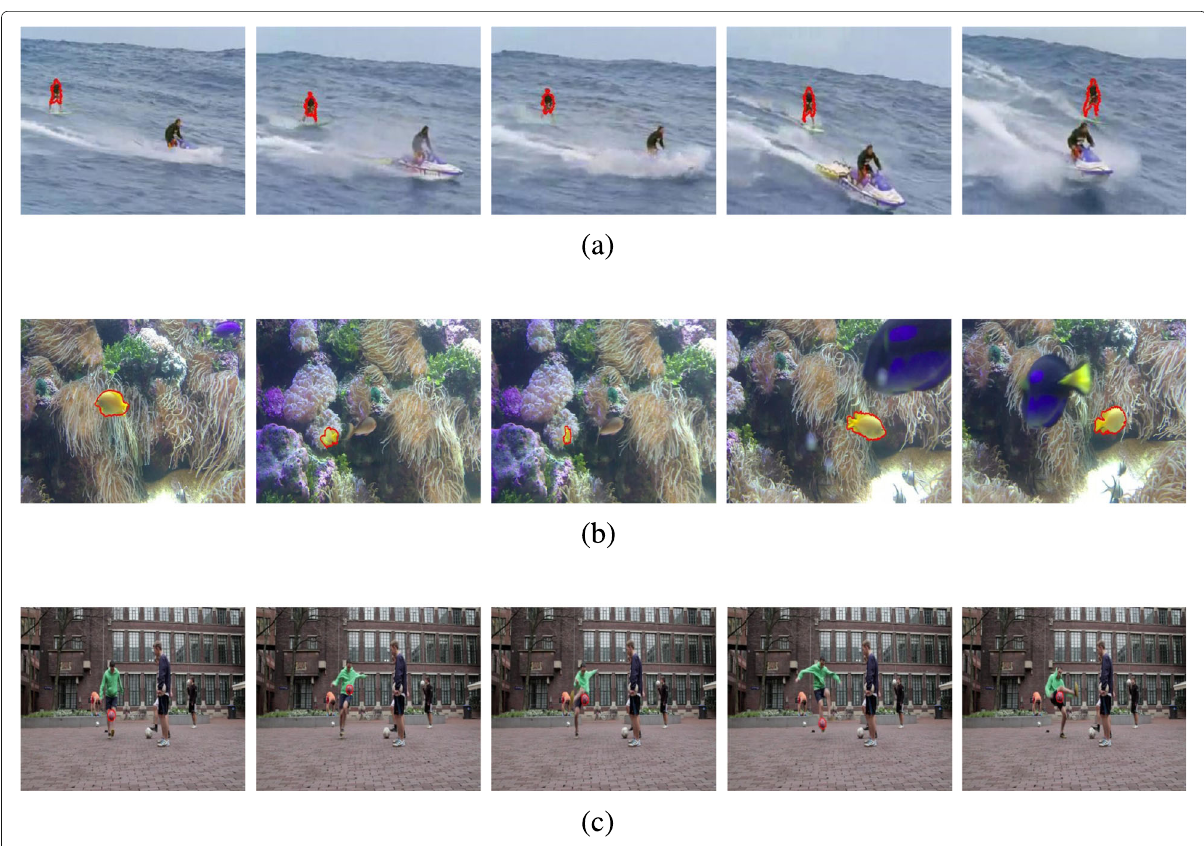
Fig. 8 Visible tracking examples of the proposed method on the VOT2014 and VOT2016 datasets. a Tracking results of the proposed method on surfing sequence of the VOT2014 dataset, for frames of 1, 34, 47, 125, and 195. b Tracking results of the proposed method on fish3 sequence of the VOT2016 dataset, for frames of 1, 238, 250, 402, and 429. c Tracking results of the proposed method on ball1 sequence of the VOT2016 dataset, for frames of 2, 24, 28, 33, and 40